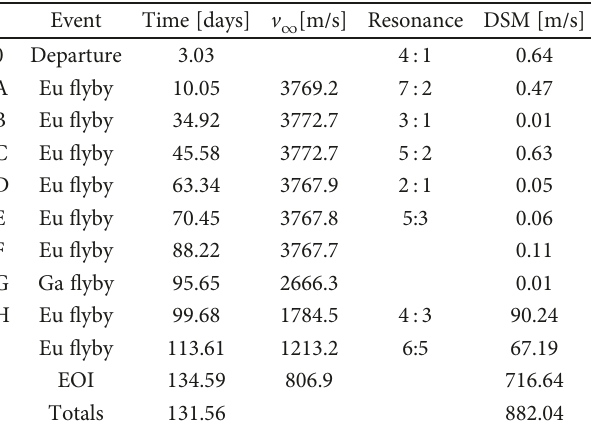
Figure 9: Tisserand graph of solution B. Axes are normalized with respect to the Europa semi-major axis. Table 3: Solution “ C ”— mission